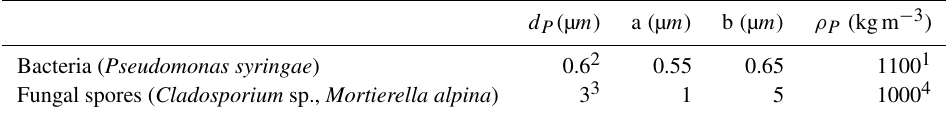
Table 1. Physical characteristics of the different PBAP types used for the model simulation of this study. a and b are the semiaxes of the prolate